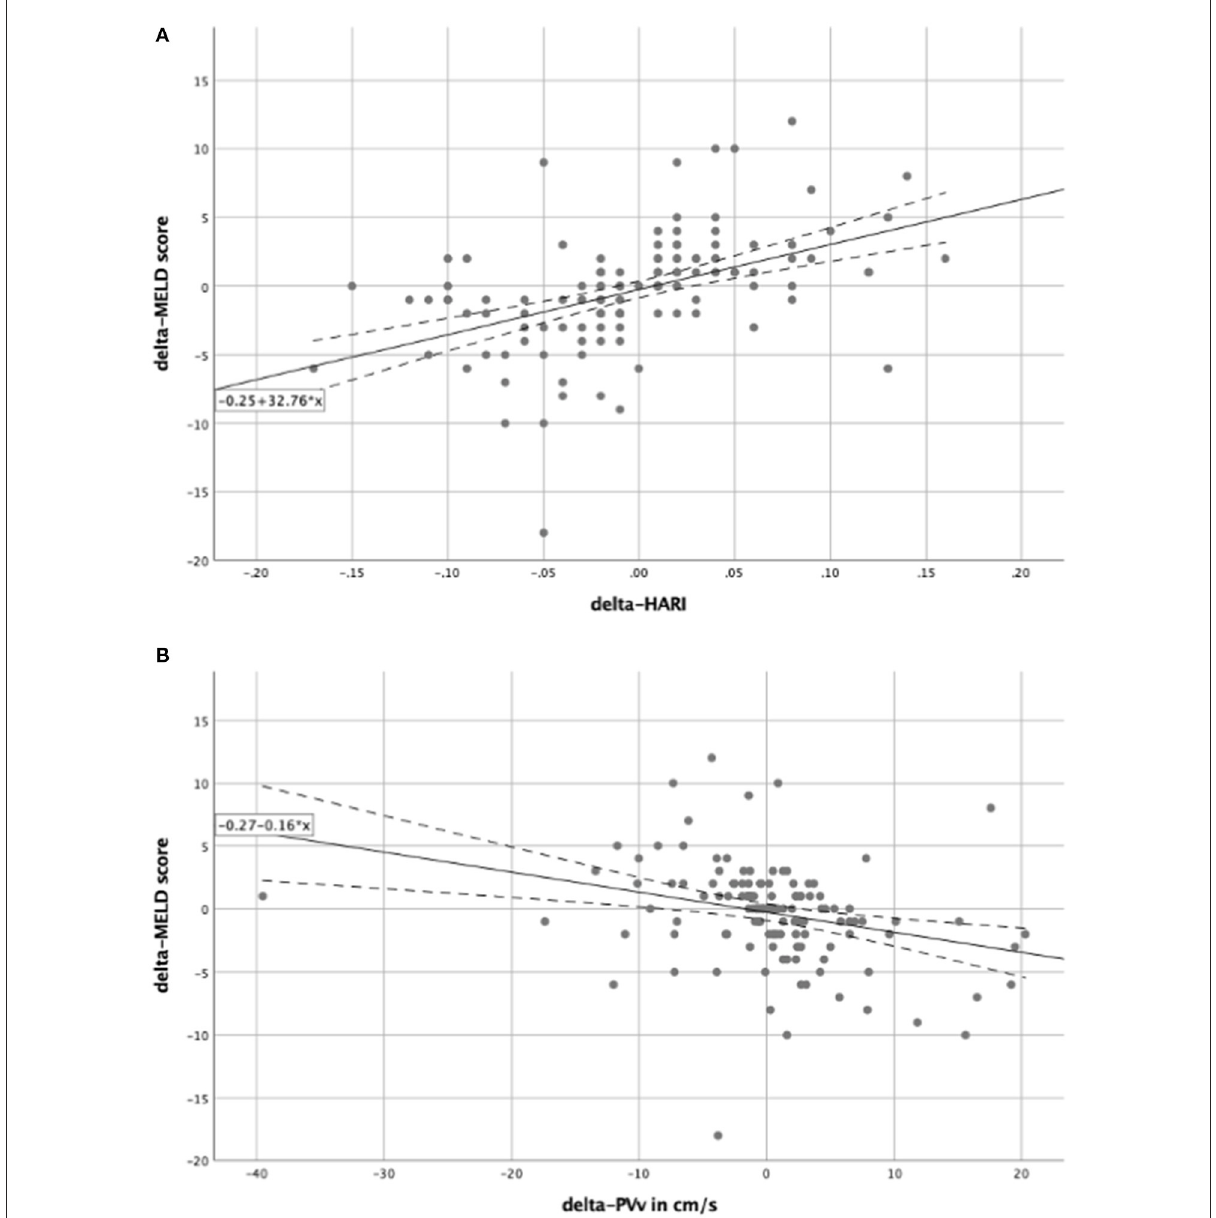
FIGURE3 Scatter plots for the correlation between delta-MELD score and the perfusion parameters. In both scatter plots, the solid line represents the regression equation, which is also shown in the box. The dashed lines equate to the 95% confidence interval. (A) Showing a positive linear correlation between the delta-MELD score and the delta-HARI; (B) showing a negative linear correlation between the delta-MELD score and delta-PVv. HARI, hepatic artery resistance index; PVv, portal vein